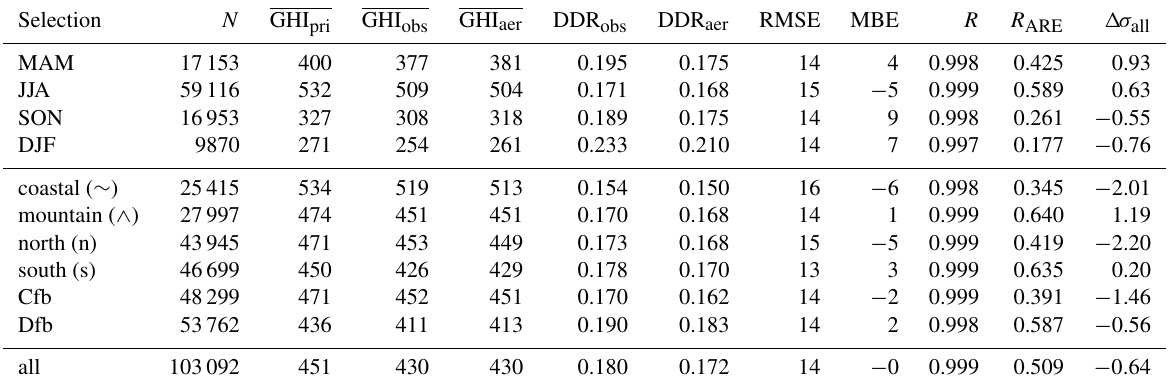
Table 6. Same as Table 5 but for global horizontal irradiance (GHI). In addition, the diffuse-to-direct-irradiance ratio is calculated for observations (DDR obs ) and simulated irradiance (DDR aer ).